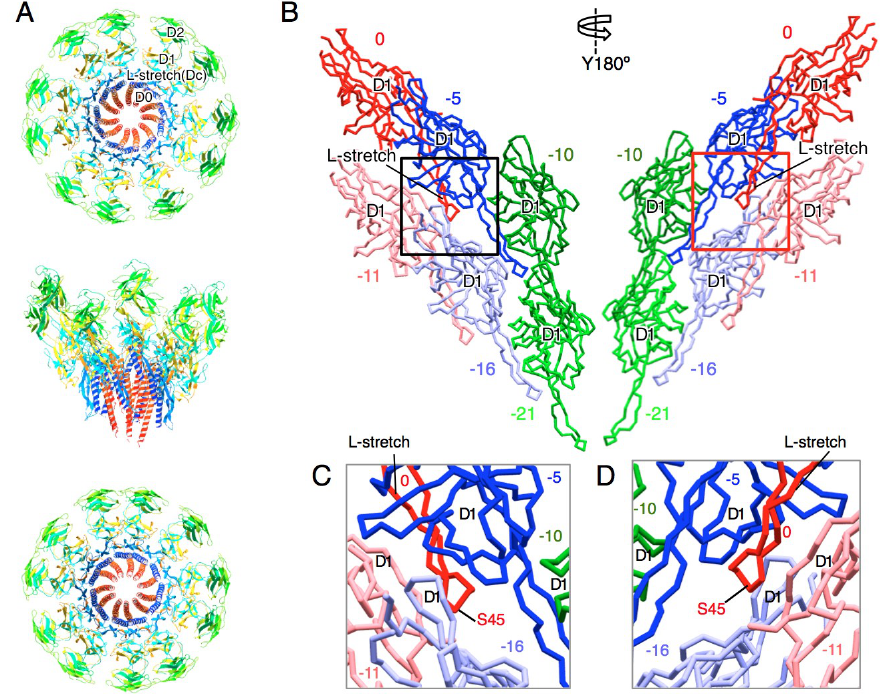
Figure 3. Structure model of the hook. ( A ) Two turns of the hook model. Eleven FlgE subunits along the one start helix are shown. Each subunit is colored from blue to red through the rainbow spectrum from the N to C terminus. Upper panel, viewed from the distal end; middle panel, side view; lower panel, viewed from the proximal end. ( B ) Subunit interaction of the D1 and the l -stretch in the hook. Six subunits in three adjacent protofilaments (two subunits from each protofilament) are shown. The number counted from the subunit 0 along the 1-start helical line is shown above or below each subunit. Left panel, view from the outside; right panel, view from the inside of the hook. ( C ) ( D ) Close up view of the L-stretch in the hook. The region in the black and red boxes in ( B ) are shown in ( C ) and ( D ), respectively. Molecular figures were drawn using MolFeat (Ver 3.6, FiatLux